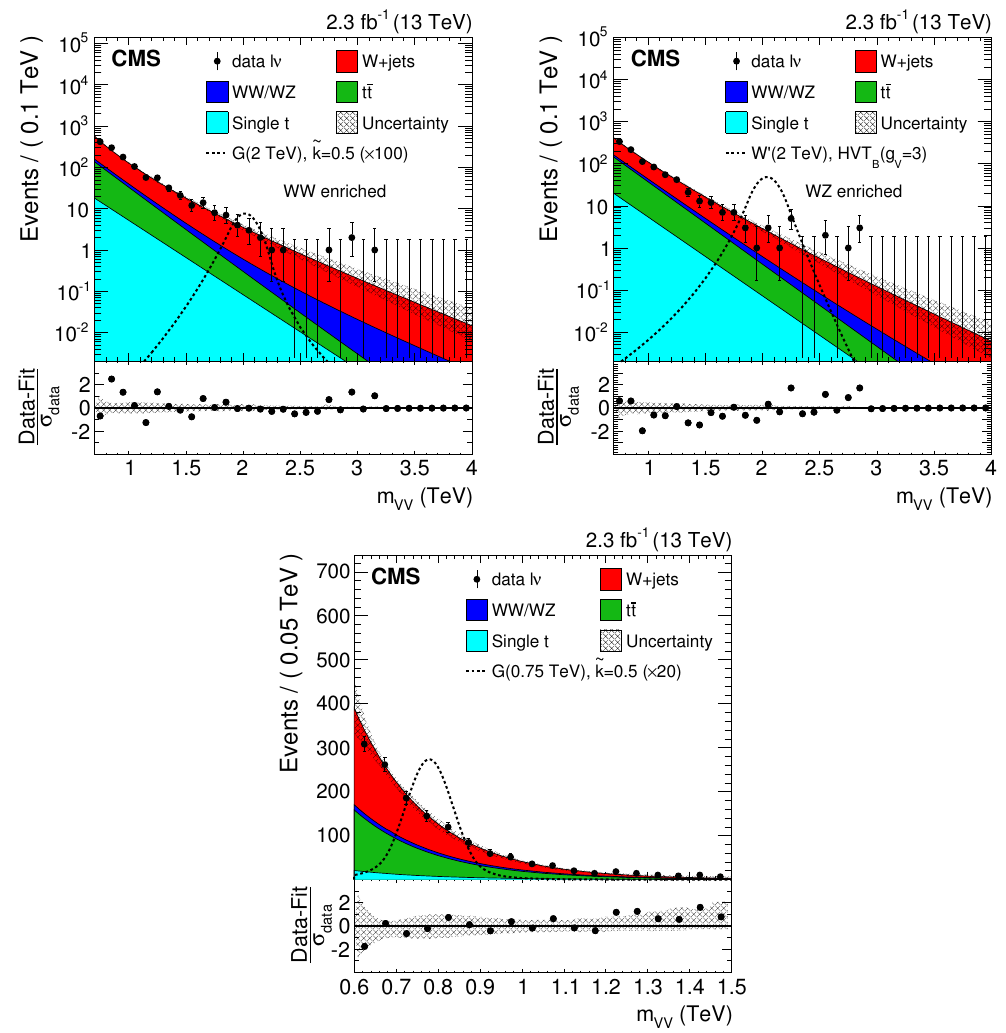
Figure 4 . (Upper plots) Final m VV distributions for data and expected backgrounds in the high- mass analysis obtained from the combined muon and electron channels in the WW-enriched (left) and WZ-enriched (right) signal regions. (Lower plot) Final m VV distributions for data and expected backgrounds in the signal region of the low-mass analysis obtained from the combined muon and electron channels. In each plot the solid curve represents the background estimation provided by the (cid:11) ratio method. The hatched band includes both statistical and systematic uncertainties. The data are shown as black points. Signal benchmarks for a mass of 2 TeV (0.75 TeV) are also shown with black dashed lines for the upper (lower) plots. In the lower panel of each plot are the bin-by-bin (cid:12)t residuals, ( N data (cid:0) N (cid:12)t )/ (cid:27) data , shown together with the uncertainty band of the (cid:12)t normalized by the statistical uncertainty of data, (cid:27) data